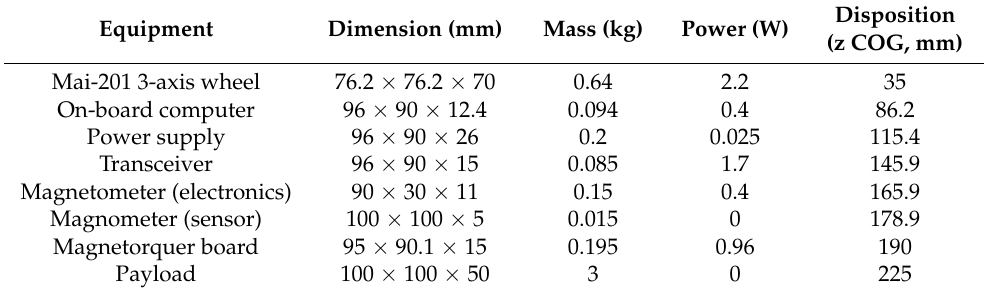
Table 3. Hardware matrix.